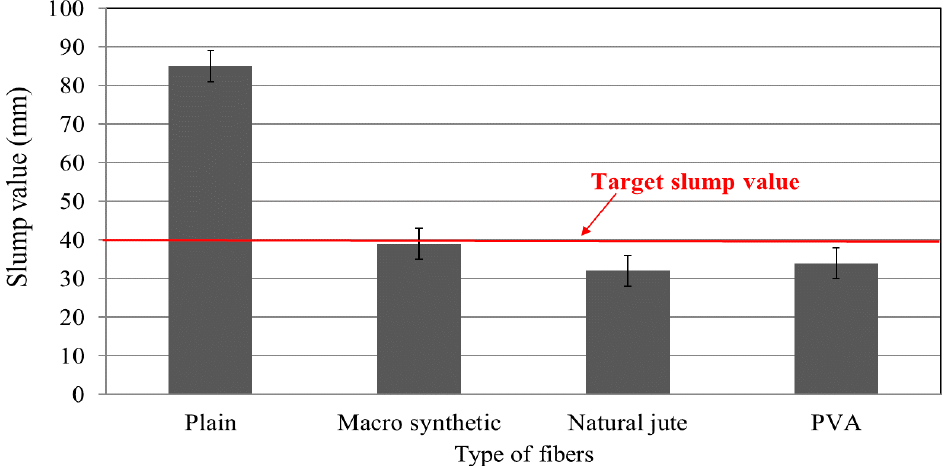
Figure 6. Slump test results.